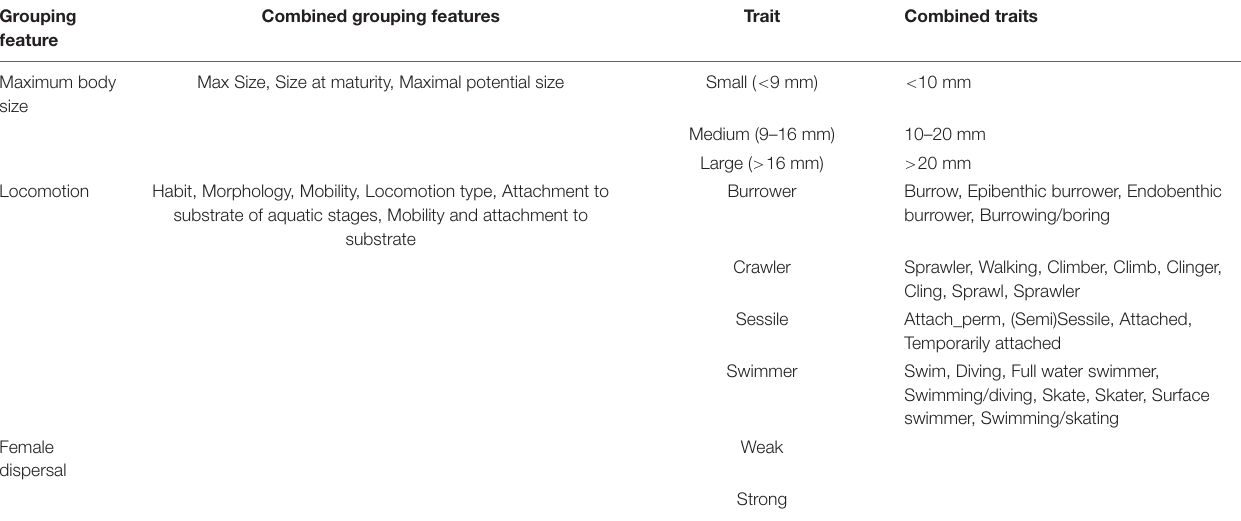
TABLE 2 | Harmonization results of different trait classification